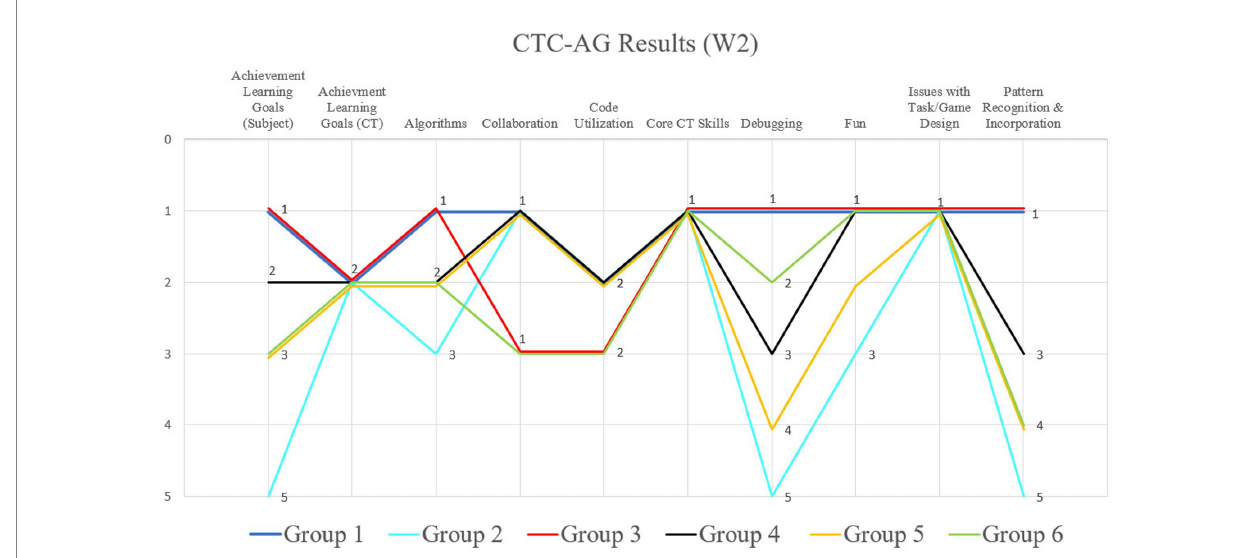
FIGURE 10 Results of the comparison of all six participating groups from workshop 2. The Y-axis shows the grades 1–5, according to the researcher, and the X-axis is showing excerpts of the CTC-AG items.